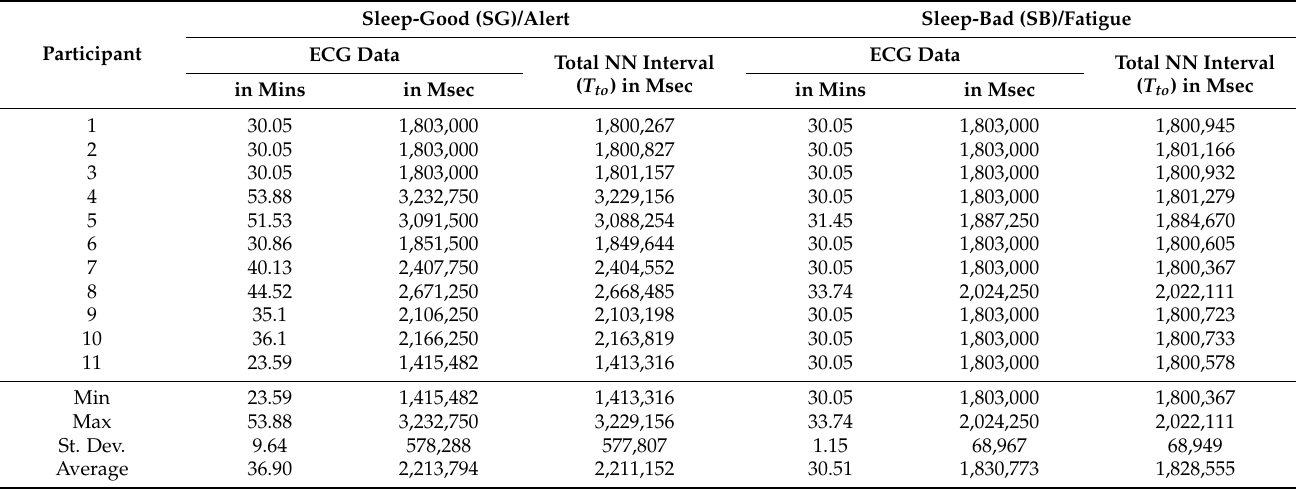
Table 2. The ECG data sample duration and total interval of each